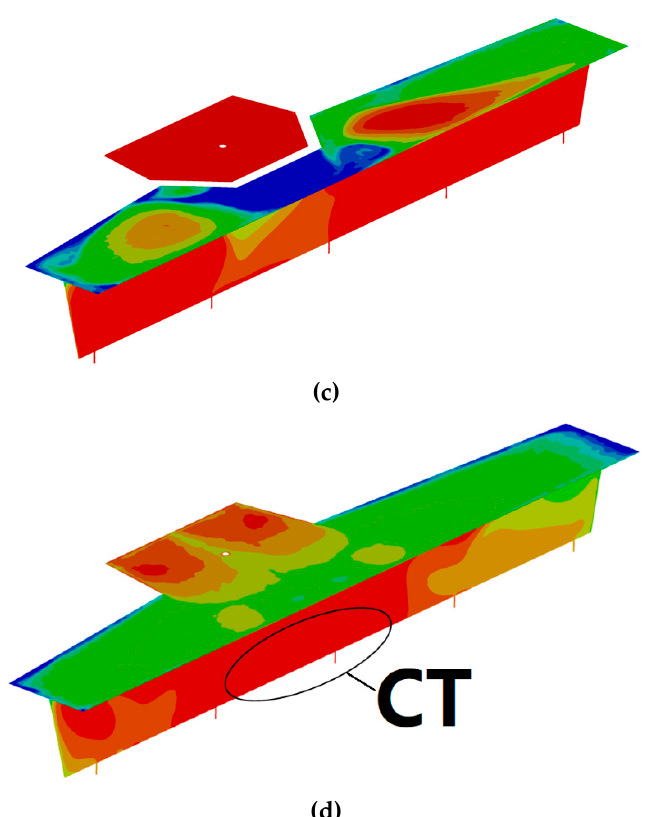
Figure 9. The static temperature distribution in a tundish with a longitudinal cross-section according to different internal structures. ( a ) The 50 mm − 20° arrangement; ( b ) 70 mm − 20° arrangement; ( c ) 90 mm − 20° arrangement; and ( d ) original arrangement. Table 3. The average temperature distribution for the molten